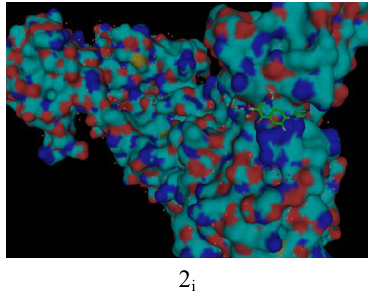
Figure 2. Different modes of synthesized